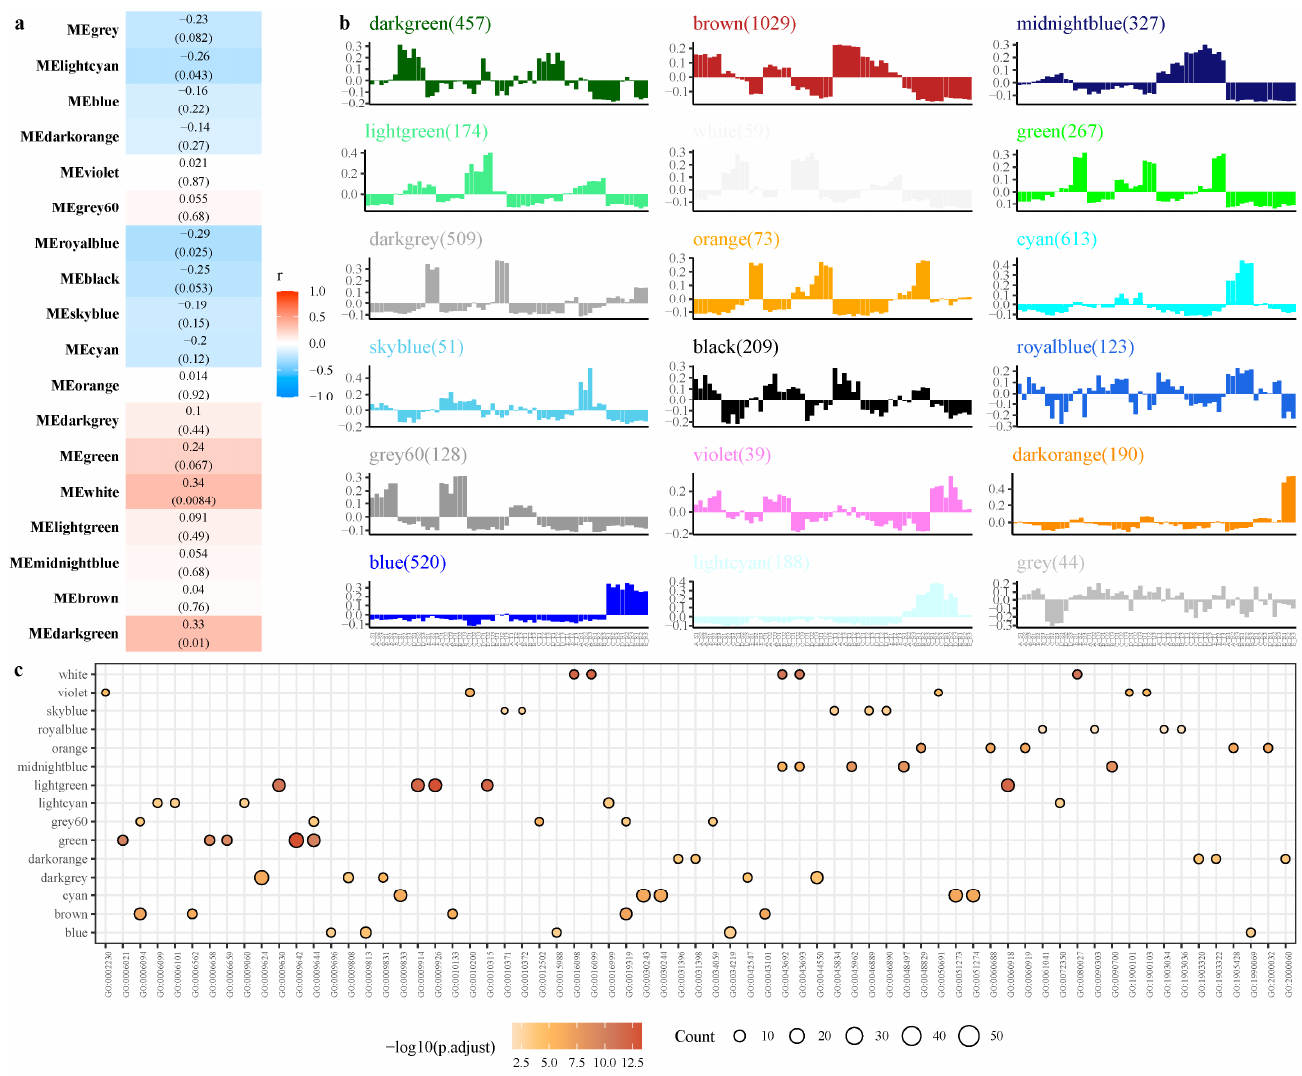
Figure 4. Weighted gene co-expression network analysis (WGCNA). ( a ): Module-trait correlation analysis; ( b ): The histograms described the eigengene expression of each module; ( c ): The GO enrichment analysis of each module (BP terms); Note: In ( a ), the trait values of the presence or absence of thorns were set to 1 for B-S, C-S, D-S, E-S, and 0 for other periods or parts. The color of each cell indicated the correlation coefficient between the module and traits (the top number in the cell represented the correlation coefficient, bottom one in parentheses represented the p -value). In ( b ), the x -axis indicates the samples, and the y -axis indicates the log 2 “relative FPKM values” of the module eigengene. In ( c ), the top 5 BP terms of each combination filtered according to the p